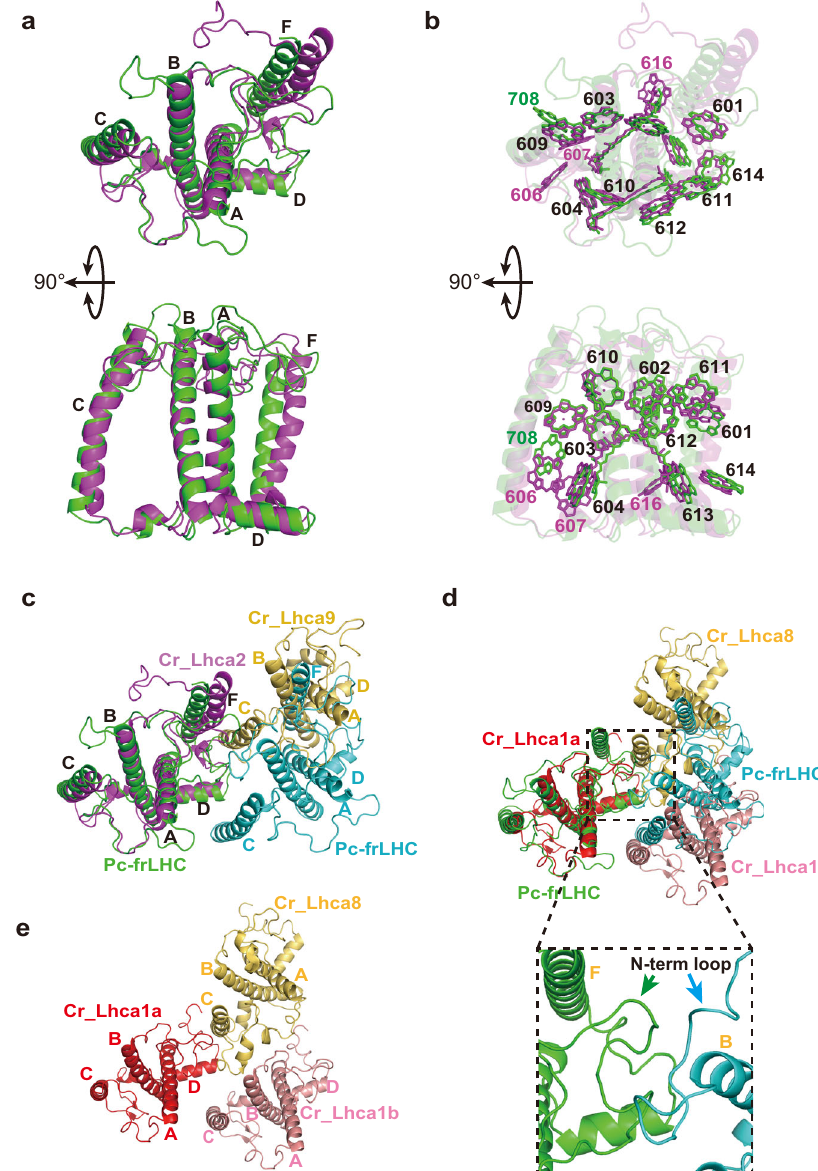
Fig. 6 | Superposition of Pc-frLHC subunit (green) and Cr_Lhca2 (magenta; PDB: 7DZ7). a Top and side views of Pc-frLHC and Cr_Lhca2 (only peptide chains) from the stromal side. Four transmembrane helices (A, B, C and F) and one amphiphilic helix (D) are labeled. b The same views as in ( a ) showing Chls and carotenoids. Chls common to both proteins are shown with black numbers. Chls unique to Pc-frLHC and Cr_Lhca2 are shown with green and magenta numbers, respectively. c ComparisonofthetwoneighboringsubunitsofPc-frLHC(greenand